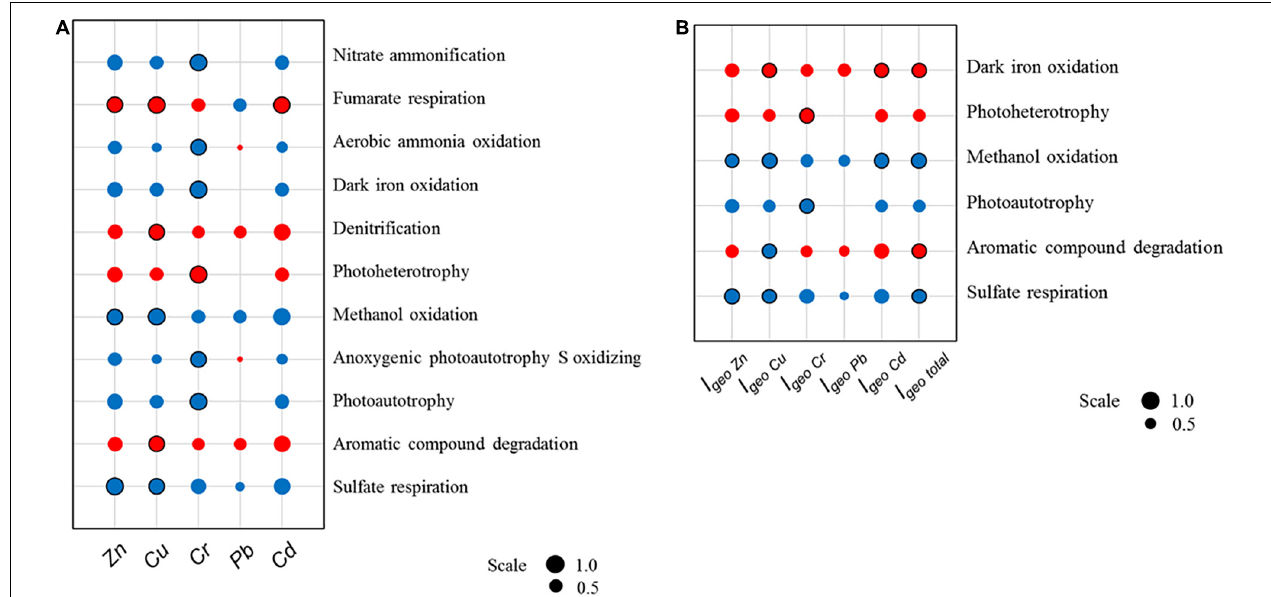
FIGURE 8 | Spearman’s correlations between (A) heavy metal concentrations or (B) heavy metal I geo indices and relative contributions toward ecological functions by microbial communities from sediment samples collected in October 2015. Red and blue colors indicate positive and negative correlations, respectively. Scale represents the numeric data of Spearman’s coefficients. Significant correlations ( P < 0.05) are indicated by a black circular border.